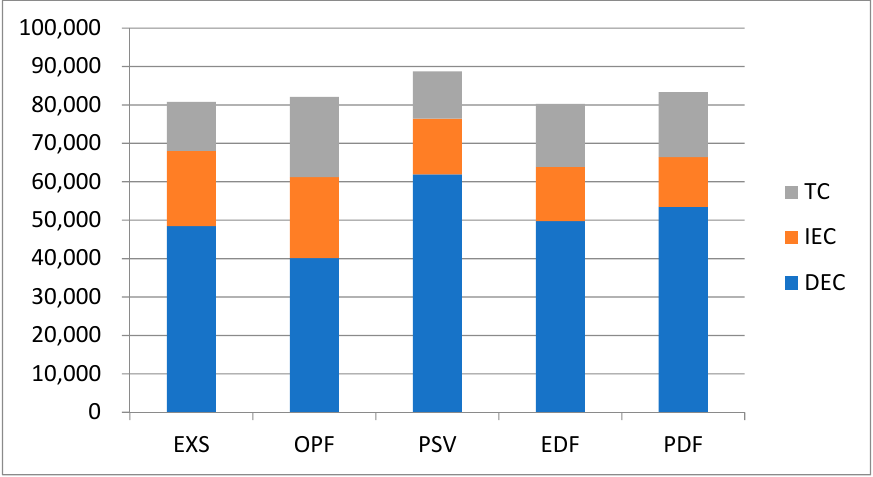
Figure 13. Cost component histograms of the optimal solutions to case 4 × 6.